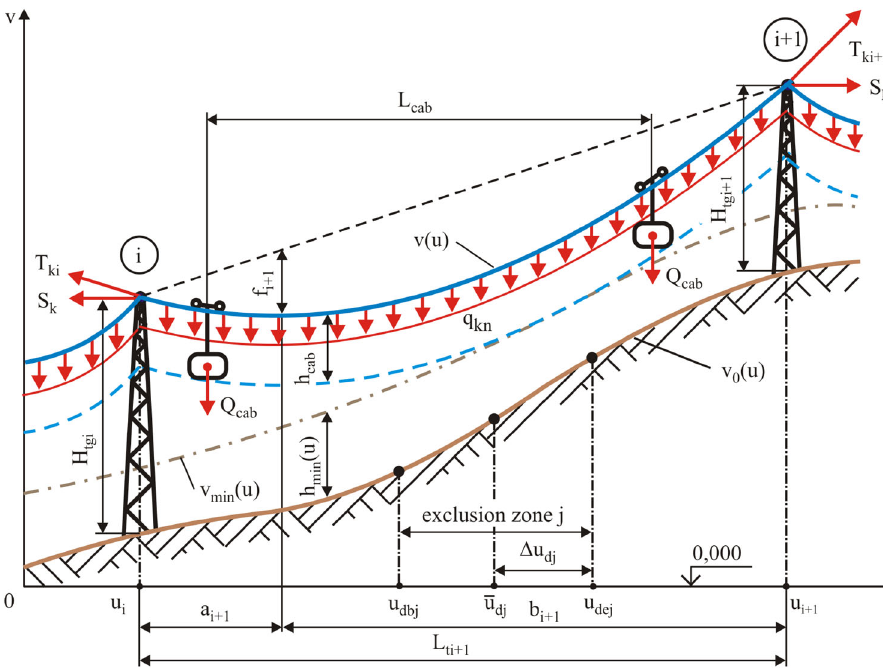
Fig. 3 The design diagram of the section of the aerial ropeway line between the neighboring intermediate